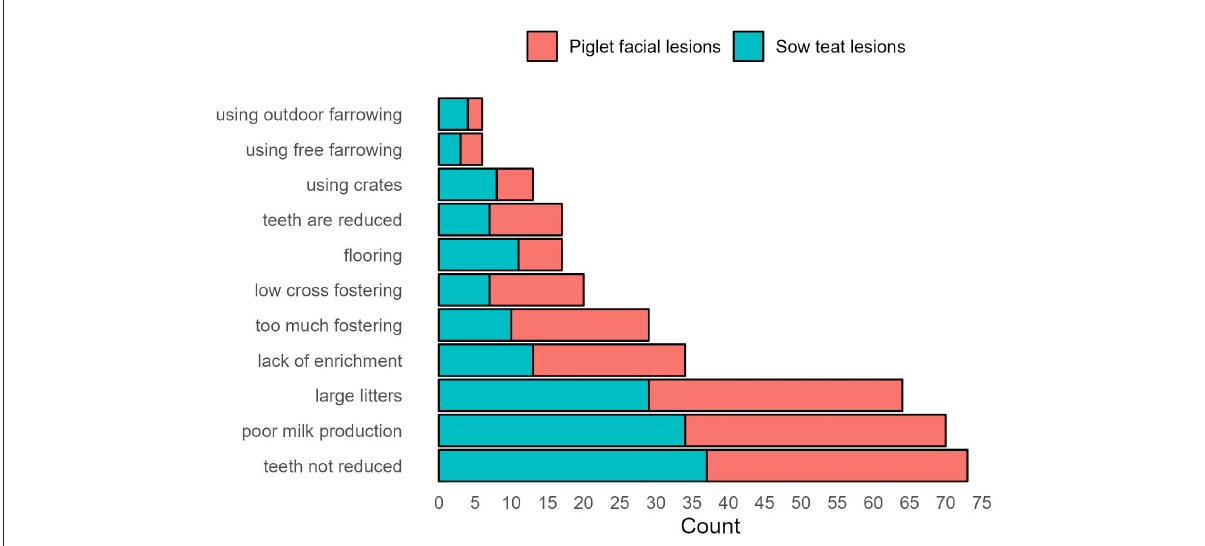
FIGURE1 Counts of responses to the question: What do you think are the main reasons for the occurrence of these problems (piglet facial and sow teat lesions)? The question included the option to select from a pre-defined listing of reasons as shown on the vertical axis. Counts of these reasons selected for piglet facial lesions (in red) and sow teat lesions (in blue) are shown from most (at the bottom) to least (at the top) selected.